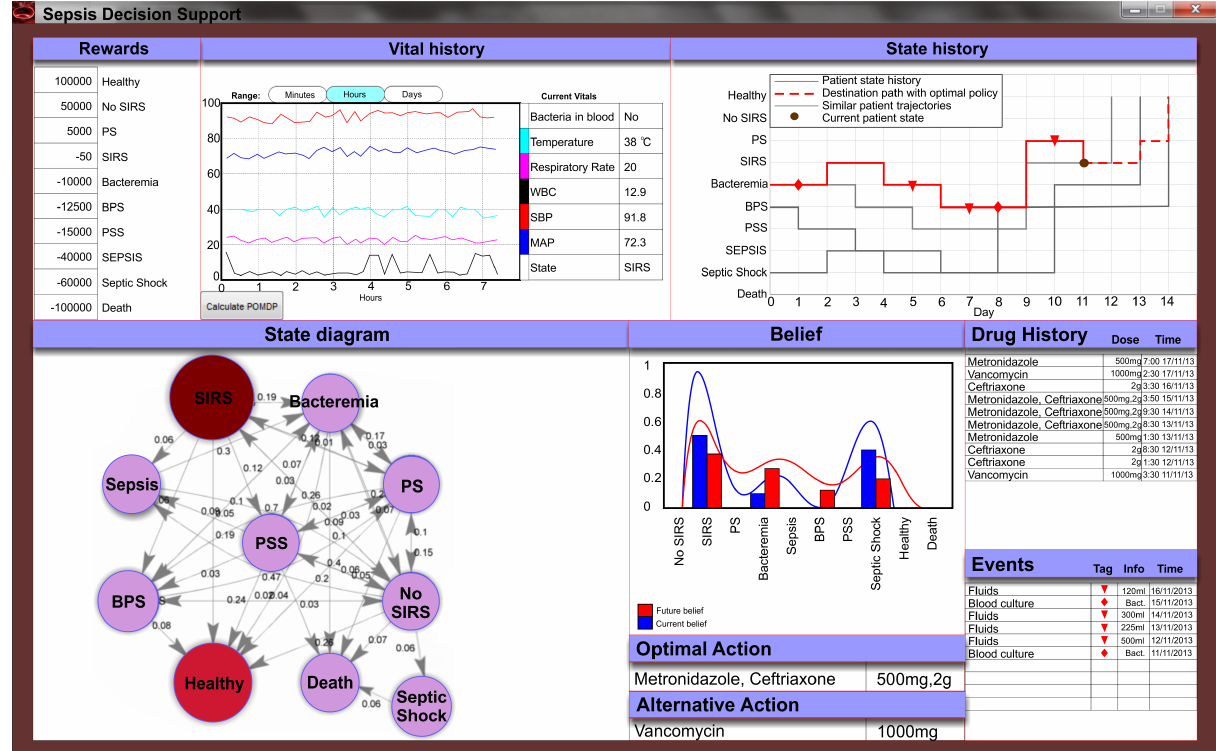
Figure 3. A graphical user interface (GUI) for the clinical decision support system. Physicians have access to real-time and historical vital history (upper left), as well as state history (upper right) for a given patient. The state history displays events, most likely path if optimal policy is to be adopted and the past trajectories of the top three patients that had similar profiles (ie, past states and vitals) to the current patient. The state diagram (bottom left) depicts the state transition probabilities and its updates based on the current state. The GUI also displays the belief distribution, optimal action given the current belief and the second best alternative action. Drug history and significant events are displayed (bottom right). The tool updates values automatically with new data, although the user has the flexibility to revise the desired reward values (upper left) and then manually trigger a recalculation of the optimal